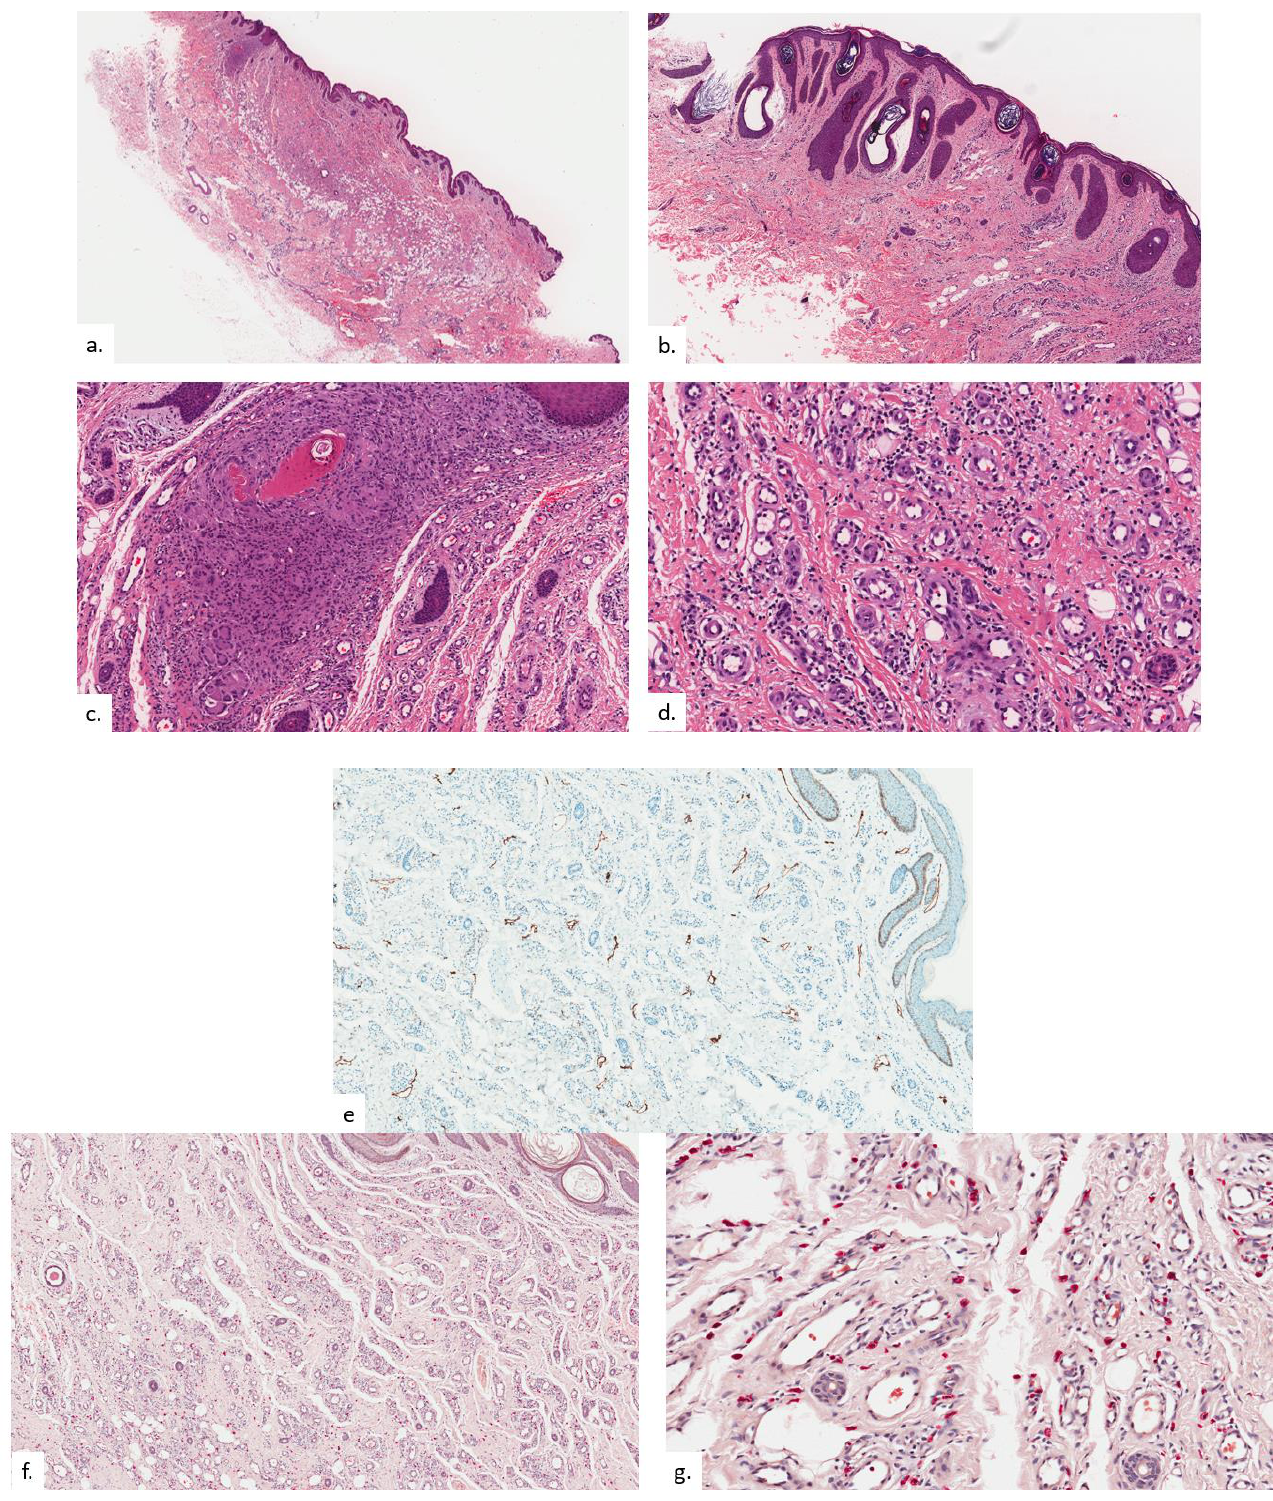
Figure 8. Patient 4. ( a ) There was compact hyperkeratosis, hyperplasia of the epidermis and follicular epithelium with a vascular proliferation throughout the dermis extending into the subcutis; ( b ) the epidermis was hyperplastic, with follicular plugging; ( c ) a focal foreign body granuloma was seen, with multinucleated giant cells surrounding keratinaceous debris; ( d , e ) there was a prominent pan-dermal proliferation of capillary-type vessels that extends into the subcutis, with a modest increase in lymphatic vessels noted on podoplanin staining; ( f,g ) increase in mast cell numbers is seen on CAE.